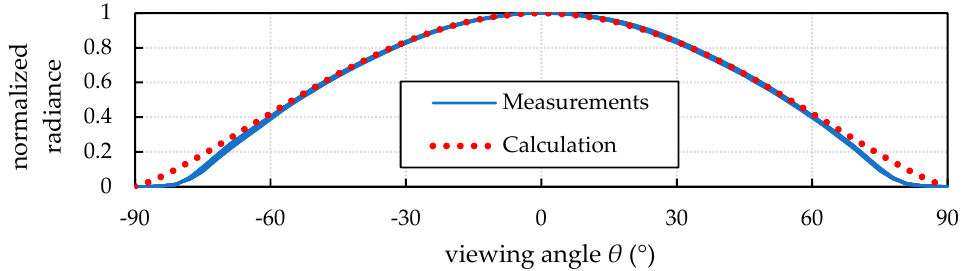
Figure 8. Comparison between 13 measurements of angular LED radiance and approximation with non-perfect Lambertian emitter.